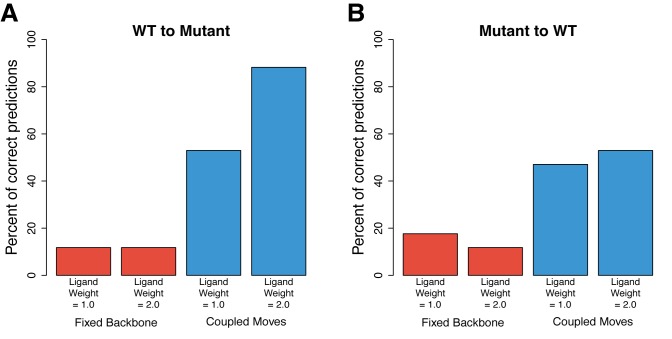
Performance of computational protein design methods on predicting specificity altering mutations.Percent of mutations predicted correctly for specificity altering mutations starting from A) the wild-type structure and B) the mutant structure. Results using fixed backbone design (red) and the coupled moves protocol (blue) are shown where protein–ligand interactions are up-weighted (ligand weight = 2.0) or not up-weighted (ligand weight = 1.0).